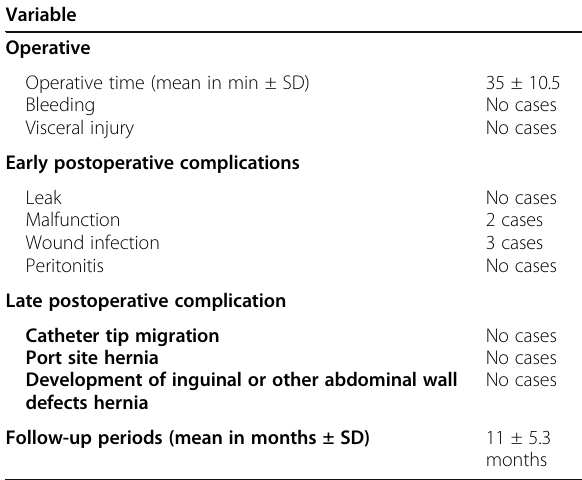
Table 2 Operative and postoperative data